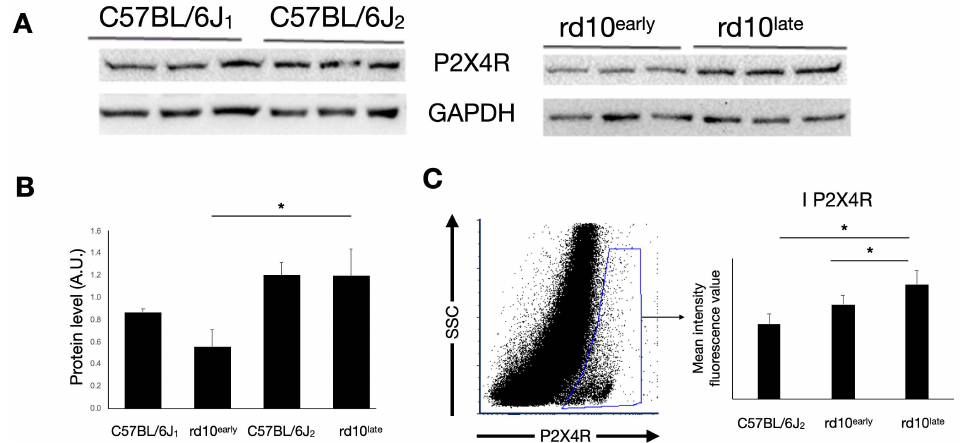
Figure 4. P2X4R expression in mouse retina. ( A ) Representative western blot and ( B ) protein quantification of P2X4R expression in C57BL/6J, rd10early, and rd10late mice. ( C ) Mean fluorescence values of P2X4R immunostaining in P2X7R-positive cells analyzed by flow cytometry in rd10early and rd10late mice compared with the control expression in C57BL/6J mice. Student’s t -test, * p < 0.05.